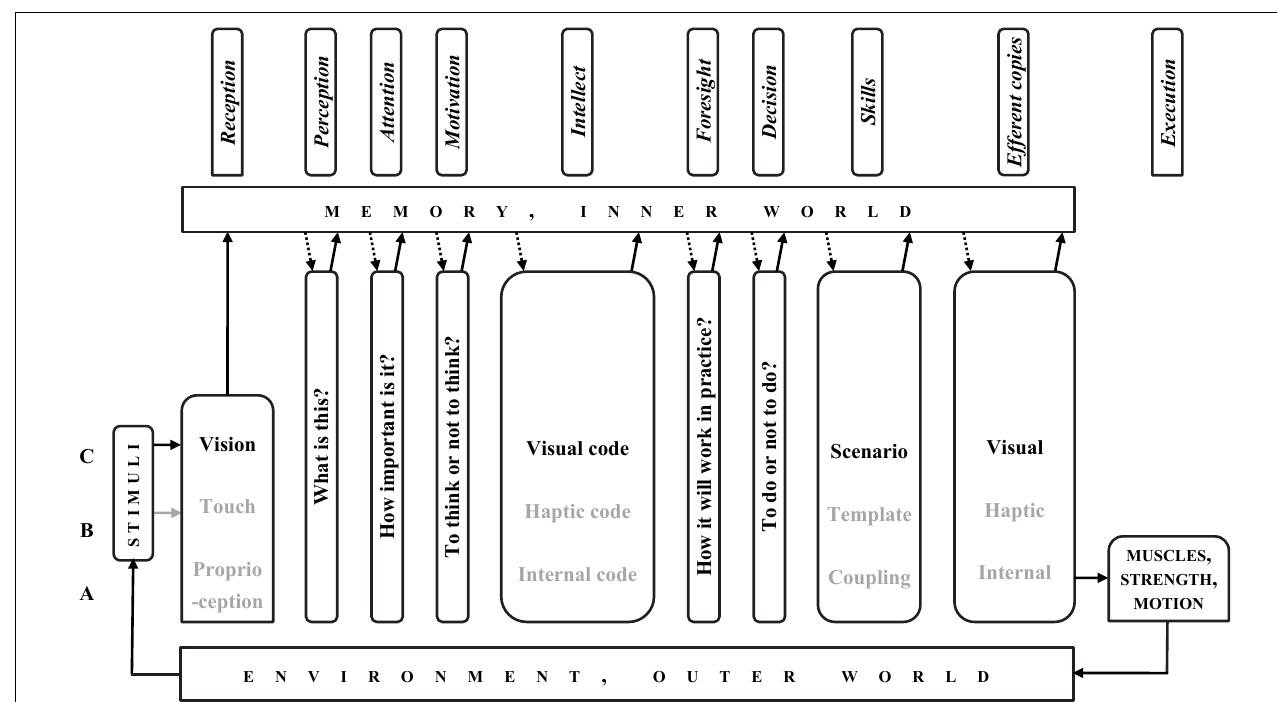
FIGURE 5 | Information processing while cycling. The A- and B-rung work “in the background,” i.e., without attention focusing.